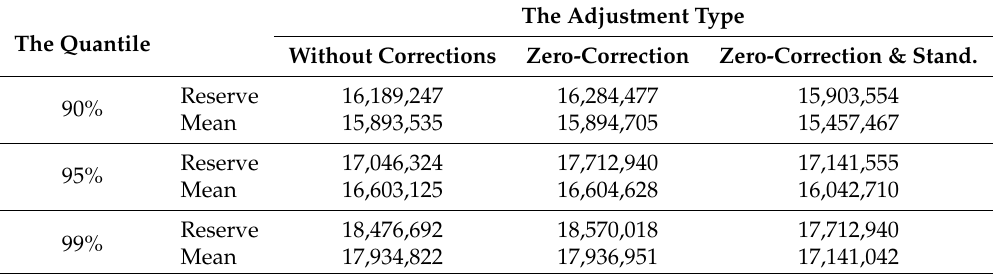
Table 9. The upper confidence limits for the total reserve and for the mean of the total reserve by the Poisson model and Pearson residuals.